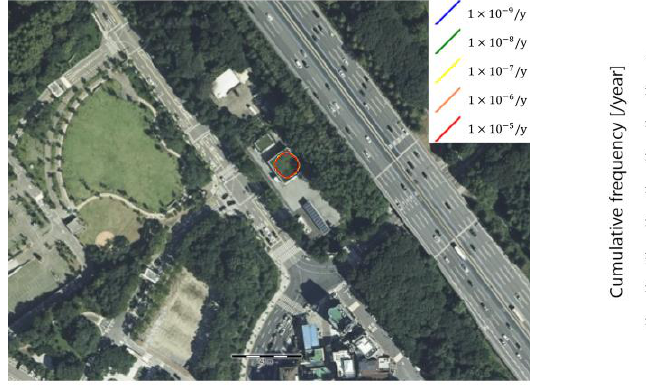
(b) Figure 6. The change in overpressure with respect to distance for ( a ) the FAHRS VCE scenario due to the rupture of the H 2 buffer tank and ( b ) the GHRS VCE scenario due to the rupture of the H 2 tube trailer. The affected distance for the overpressure level of 137.9 mbar (yellow contour in Figure 5) is shown for both cases. 4.2. Risk Analysis The risk assessment results of both the FAHRS and GHRS cases were analyzed. The IR and SR of the two systems were analyzed using the commercial risk analysis software RISKCURVES v12. The IR contour and the plot of the frequency of events that causes at least N fatalities (F-N curve) are presented in Figure 7 for the FAHRS system and in Figure 8 for the GHRS system. The overall fatality range for the FAHRS system is relatively small compared to that of the GHRS system (Figure 7a), showing individual risk contours af- fecting only the region near the HRS. As seen in Figure 7b, the societal risk for the FAHRS does not exceed the safety limit, showing that it can be operated safely without additional risk mitigation measures. The actual risk values for each risk scenario of the FAHRS sys- tem and their relative contributions are provided in Table 5. For the FAHRS system, the